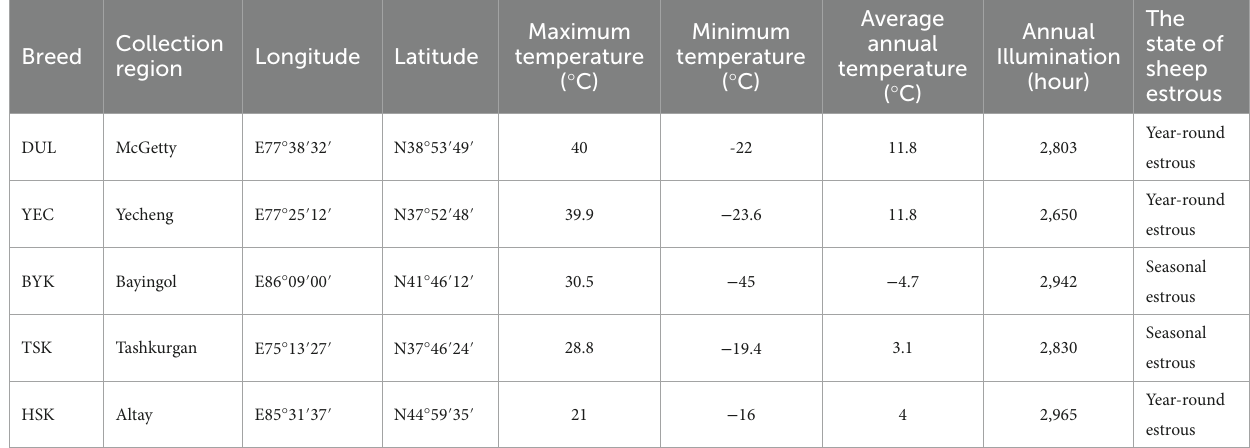
TABLE 1 Information on the location of five sheep breeds in Xinjiang, China.